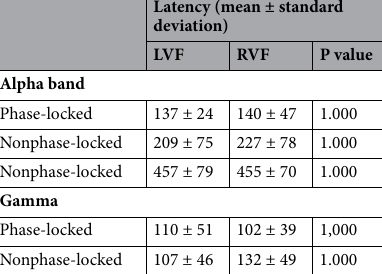
Table 1. Latency values for phase-locked and nonphase-locked alpha and gamma bands. LVT left visual field, RVF right visual